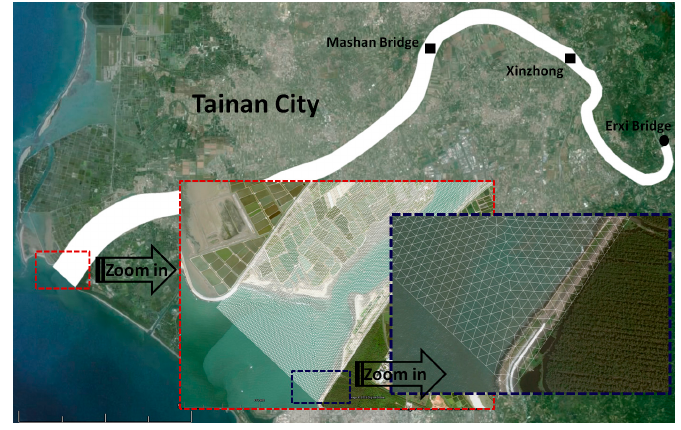
Figure 4. High resolution unstructured grids in the Tsengwen River for hydrodynamic modeling.